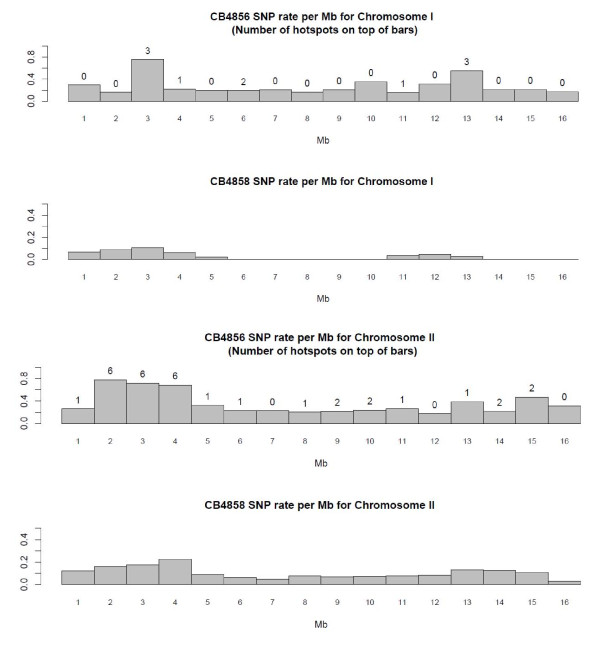
SNP rate per Mb for Chromosomes I and II in CB4856 and CB4858.